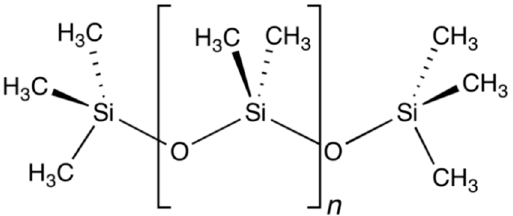
Figure 1. The constitutional formula of polydimethylsiloxane.